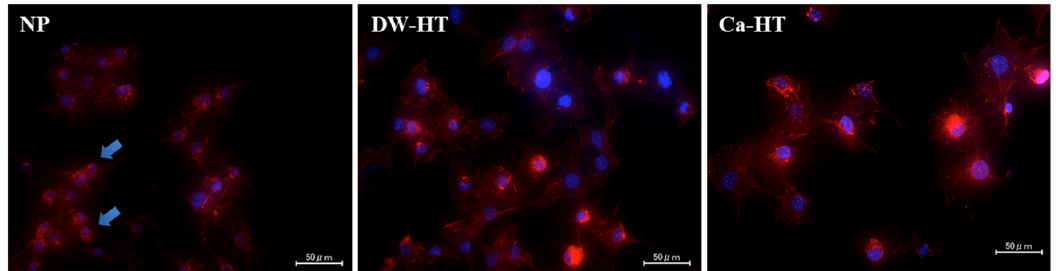
Figure 7. Fluorescent microscopic observation of MC3T3-E1 cells seeded onto the substrata. After 1 h of incubation, cells seeded onto both DW-HT and Ca-HT were well spread and their cell processes were prominent. Some cells seeded onto NP have also spread; however, others were still round in shape without extended cell processes (arrows).